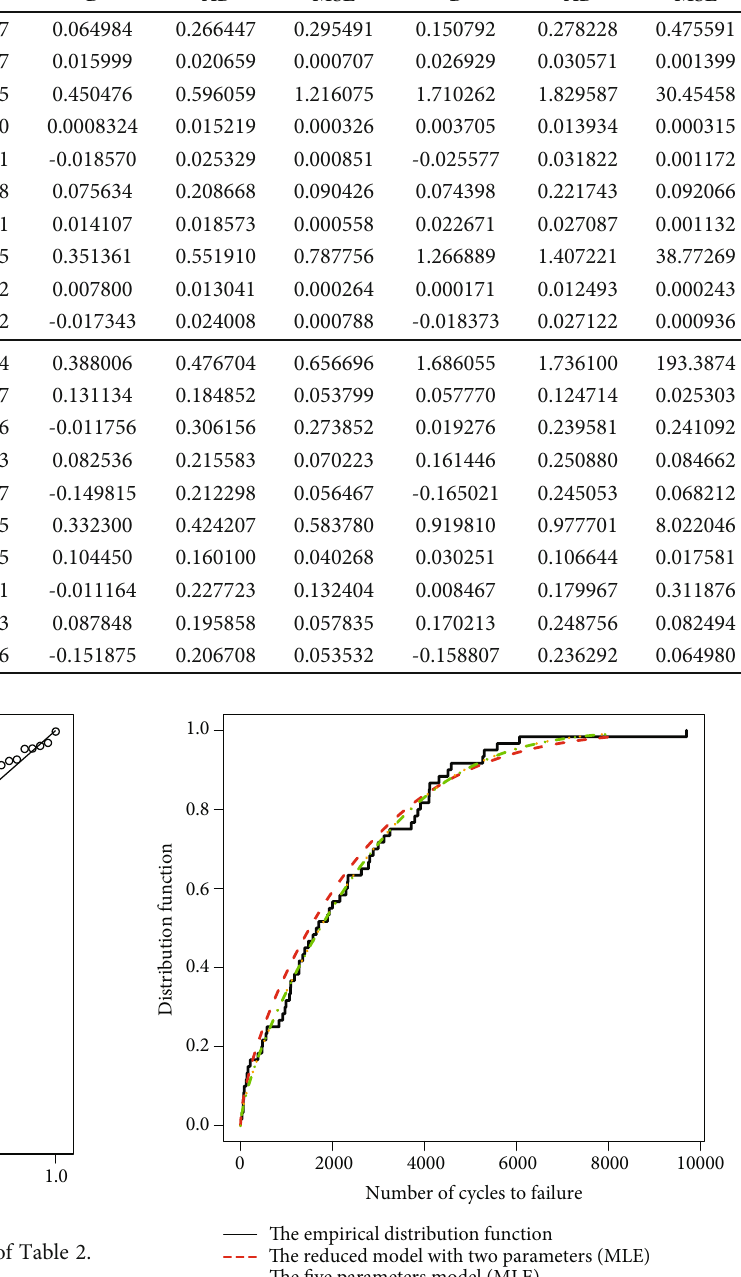
The EM algorithm The LSE The MLE